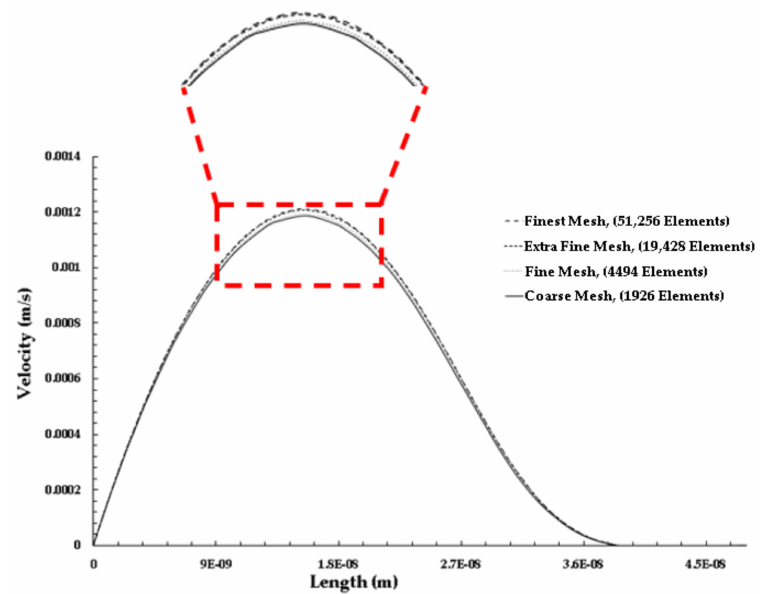
Figure 10. Plot of the velocity profile at the center of the